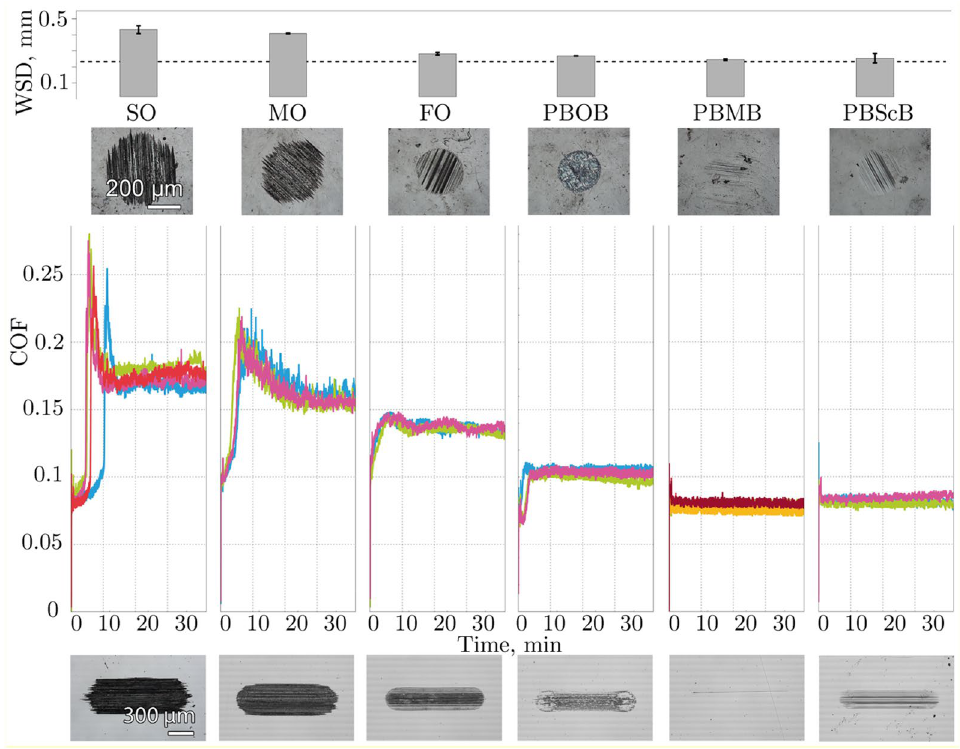
Figure 2. Ball wear scar diameters (WSDs), friction traces and optical images of the wear scars on the ball and PD surfaces for constant load tests involving the lubricants shown. Different coloured traces represent different replicate experiments. The dashed line in the WSD plot indicates the initial Hertzian contact